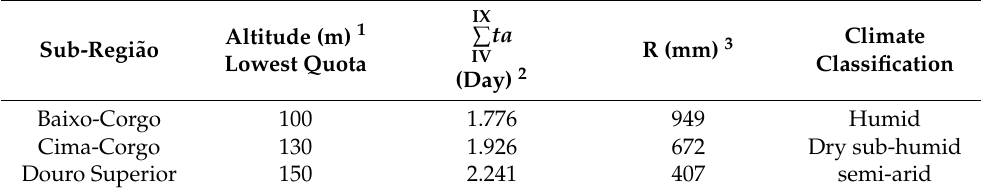
Table 1. Climatic characteristics of the DDR (Demarcated Douro Region) sub-regions. Adapted from Magalhães [4].